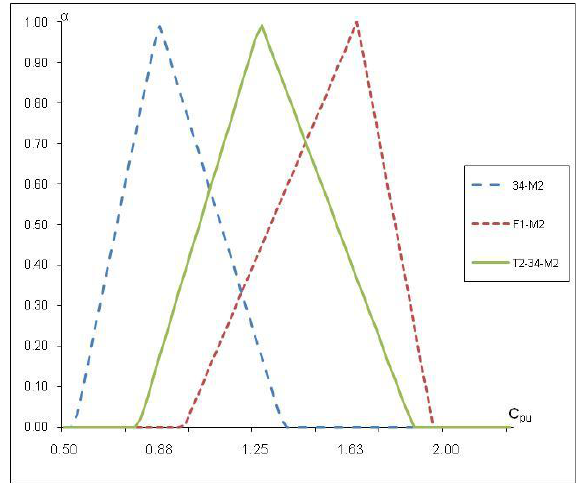
Fig. 11. The membership functions of the index for three route